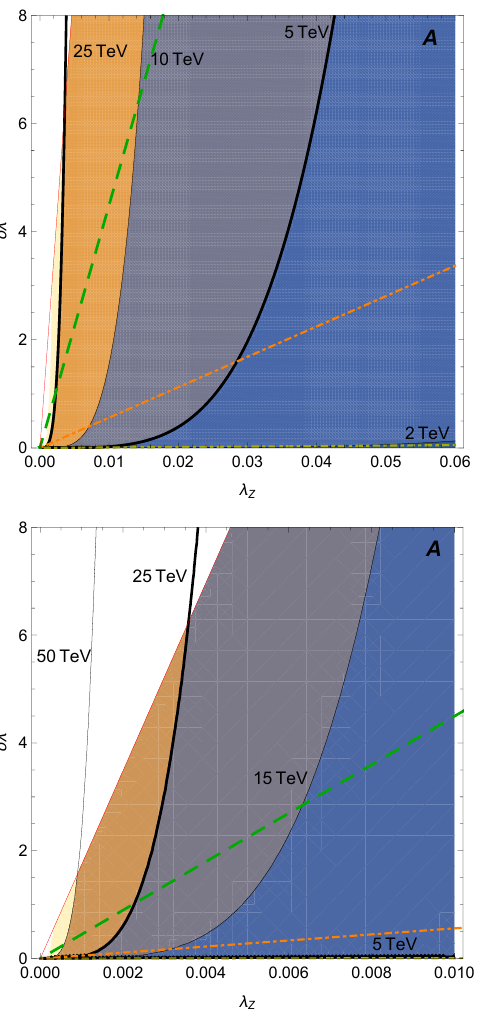
Figure 4 . Estimated (maximal) NP mass M max in dependence on the triple-gauge coupling ( (cid:21) Z ) and the variation in the triple-Higgs self coupling ( (cid:14)(cid:21) ) in Scenario A (left) and B (right). The colored lines denote NP couplings of g (cid:3) = 1 ; 4 ; 8 ; 4 (cid:25) , respectively (from yellow to red), and the lower panel shows a zoom into the plots of the upper panel. See text for